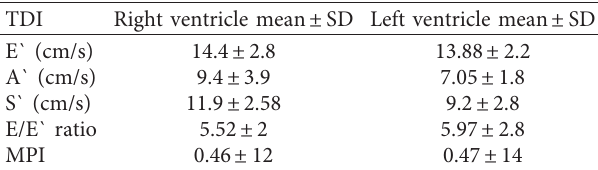
Table 4: TDI data of RV and LV at the last